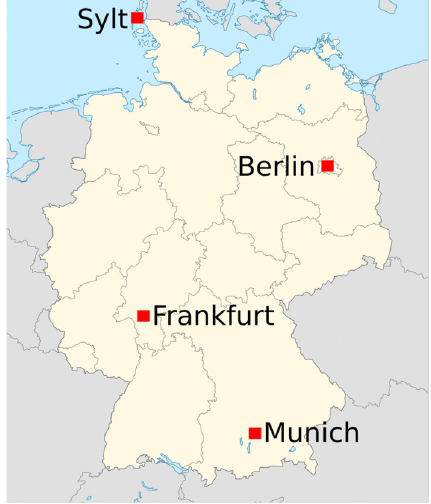
Figure 1. Map of Germany and position of the 4 locations included in the study.